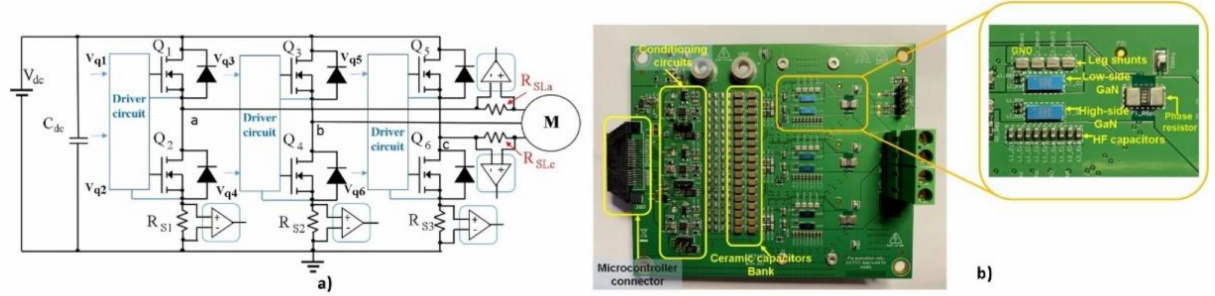
Figure 7. ( a ) Inverter board schematic with current sensing arrangement on the phase and in the switching leg ( b ) Photo of the top side of the inverter board with a zoomed view of a half-bridge relative to the phase